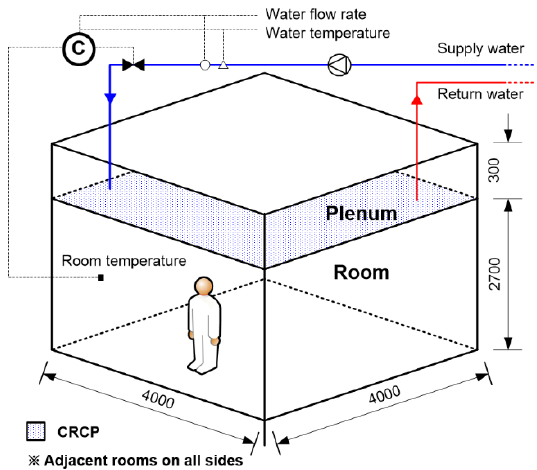
Figure 5. Modeling of room and CRCP.